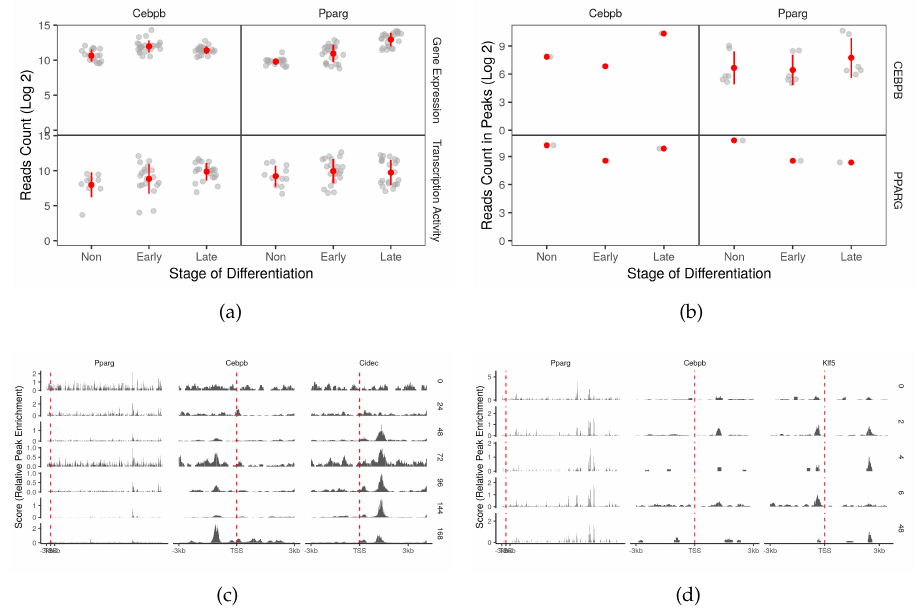
Figure 6. Auto-regulation and feedback loops of the adipogenic transcription factors. ( a ) The reads count of two adipogenic transcription factor coding genes in RNA-Seq samples (n = 66) were used to represent the gene expression. The reads count in peaks of POLR2A in genomic region of two adipogenic transcription factor coding genes from ChIP-Seq samples (n = 12) was used to represent the transcription activity. ( b ) The reads count in peaks of CEBPB and PPARG ChIP-Seq samples was used to represent peak enrichment. The peaks from the ( c ) PPARG and ( d ) CEBPB ChIP-Seq samples were visualized by the time point and position around the transcription start site ( ± 3 kb). Cidec and klf5 were used as positive control